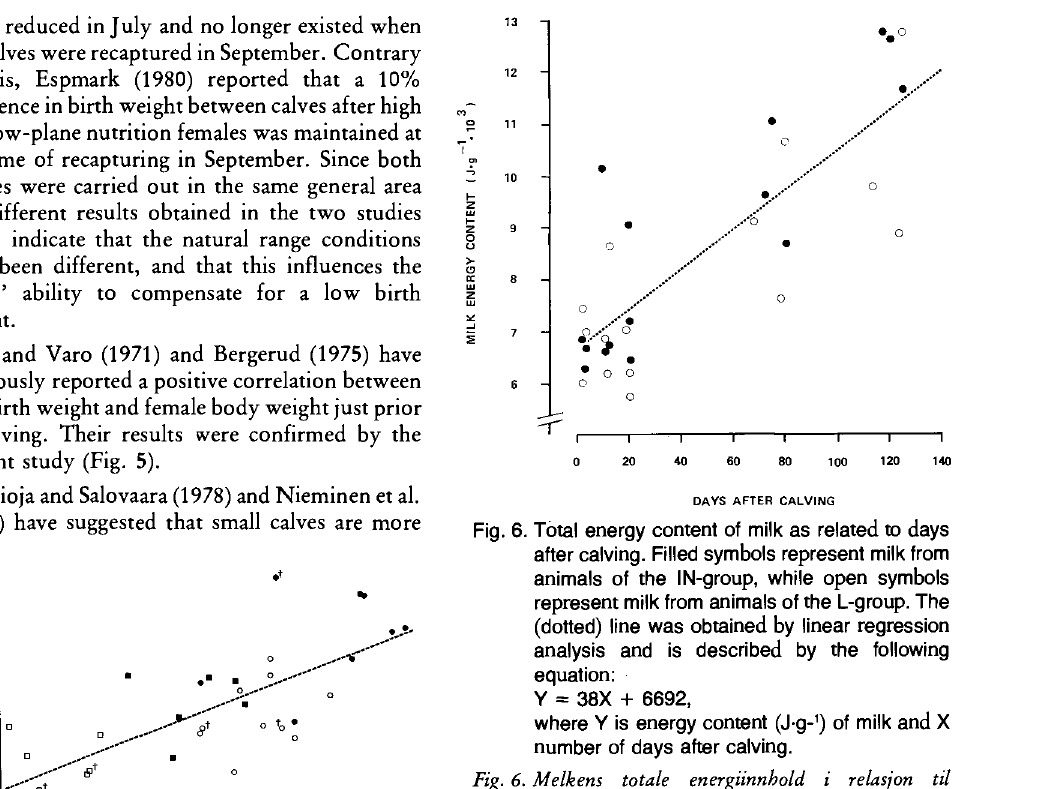
Fig. 6. Total energy content of milk as related to days after calving. Filled symbols represent milk from animals of the IN-group, while open symbols represent milk from animals of the L-group. The (dotted) line was obtained by linear regression analysis and is described by the following equation: Y = 38X + 6692, where Y is energy content (J-g- 1 ) of milk and X number of days after calving. Fig. 6. Melkens totale energiinnhold i relasjon til tidspunkt etter kalving. Lukkede symboler angir prøver fra tilleggsforete simler, mens åpne symboler angir melkeprøver fra simler pd lav-diett. Hvert punkt angir gjennomsnittsver dien for tre målinger. Den stiplede linjen er fremkommet ved linear regresjonsanalyse og kan beskrives av følgende formel: Y = 38X + 6692 hvor Y er melkens totale energiinnhold (J-g- 1 ), og X er antall dager etter